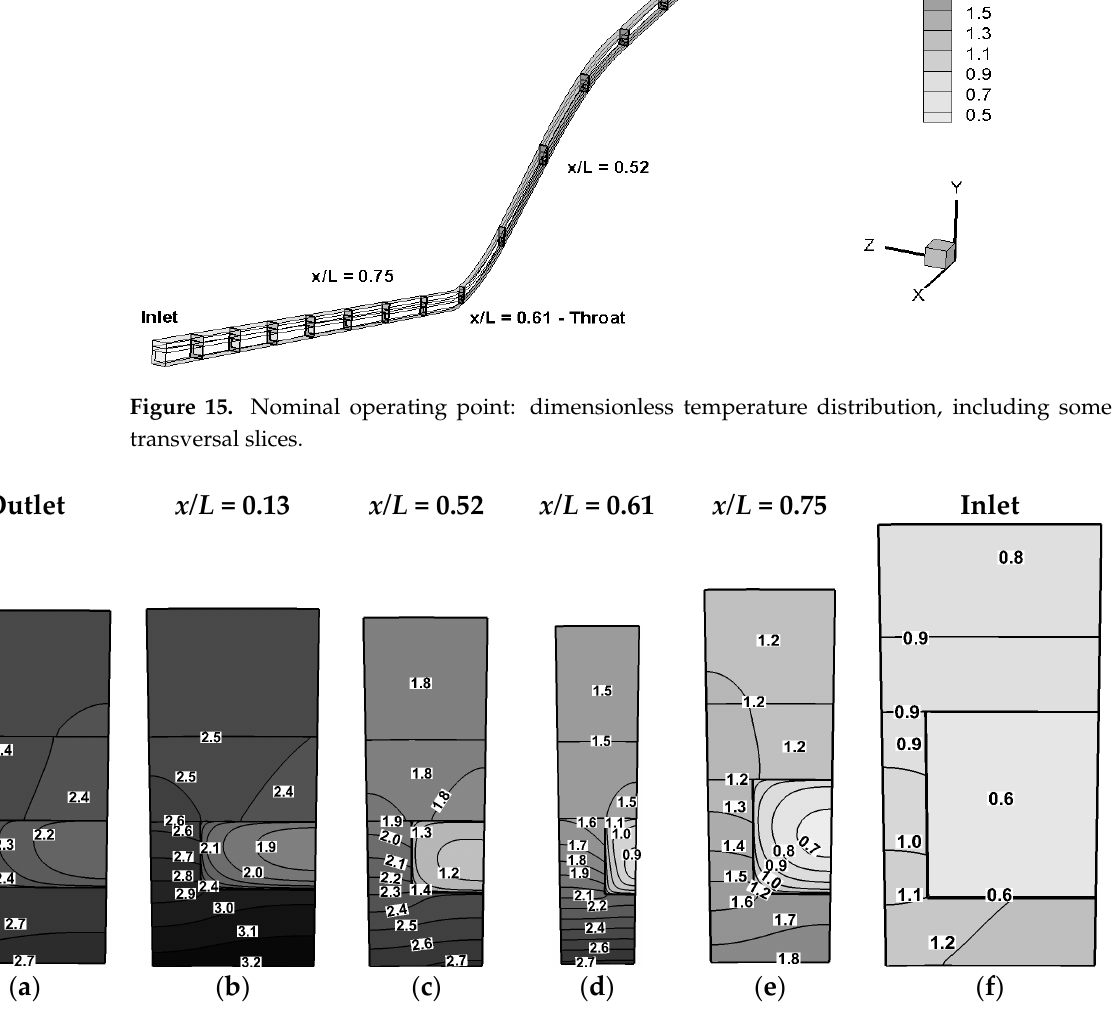
Figure 16. Nominal operating point: dimensionless temperature field, transversal slices at: ( a ) outlet section, ( b ) x/L = 0.13 (reattachment-point region), ( c ) x/L = 0.52 (corresponding to maximum specific heat); ( d ) x/L = 0.61 (throat section and fluid bulk temperature equal to critical values); ( e ) x/L = 0.75; ( f ) inlet section.